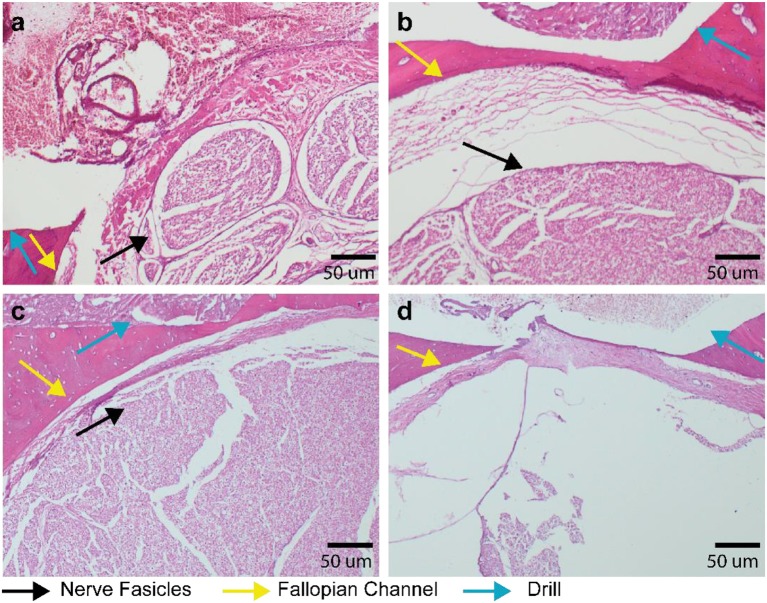
Histopathology of lateral trajectories at critically low distance to the fallopian channel (facial nerve canal). Decalcified mastoid bone slices with hematoxylin and eosin staining. (a) Trajectory 2.3–Facial nerve in close proximity to the drilled hole but without visible destruction of the nerve fascicles. (b) Trajectory 2.4 with 6 μm distance (measured in μCT) between drill and fallopian canal, the black arrow indicating intact facial nerve fascicles. (c) Trajectory 3.0 with 10 μm distance between drill and fallopian channel and with intact facial nerve fascicles. (d) Trajectory 3.4 with facial nerve not visible (due to a technical artefact) and an intact epineurium.